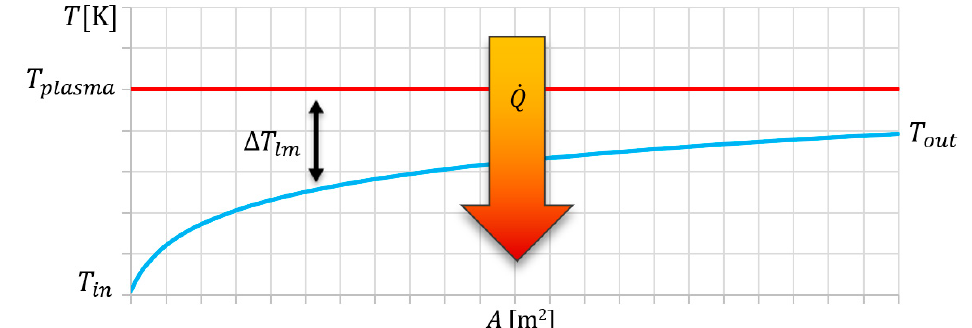
Figure 2. Generalized heat exchanger temperature profile.